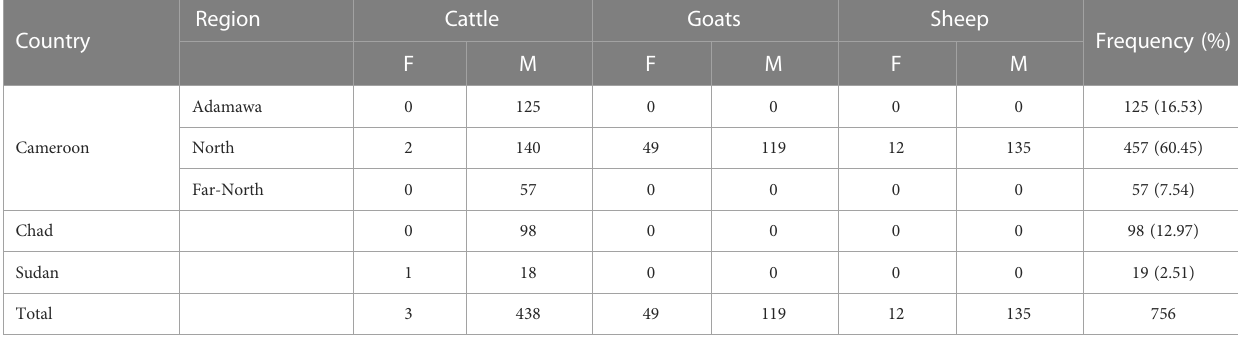
TABLE 1 Description of the animal population included in the study.